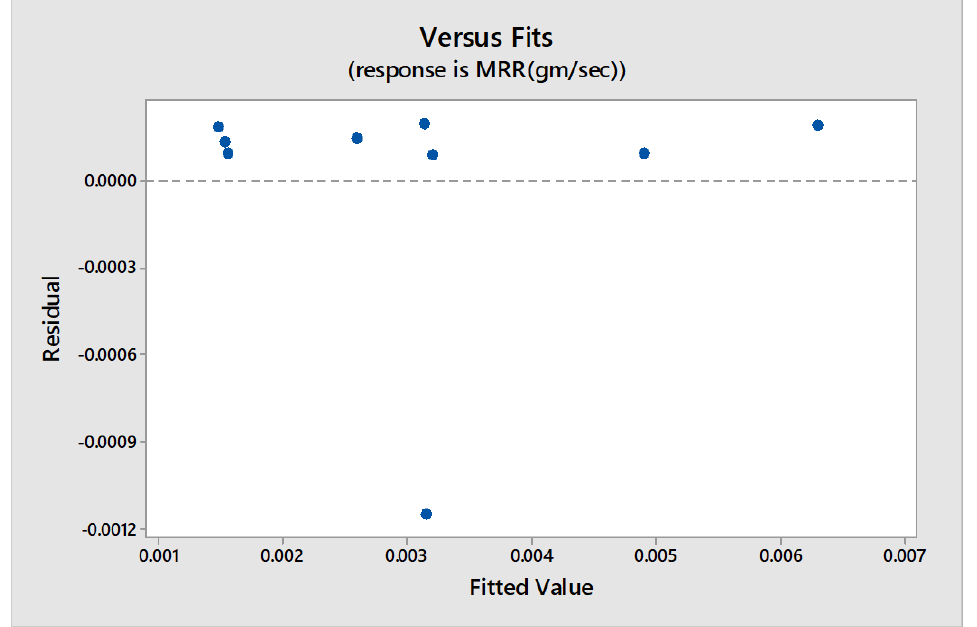
Fig. 4. Residuals versus fits plot for material removal rate